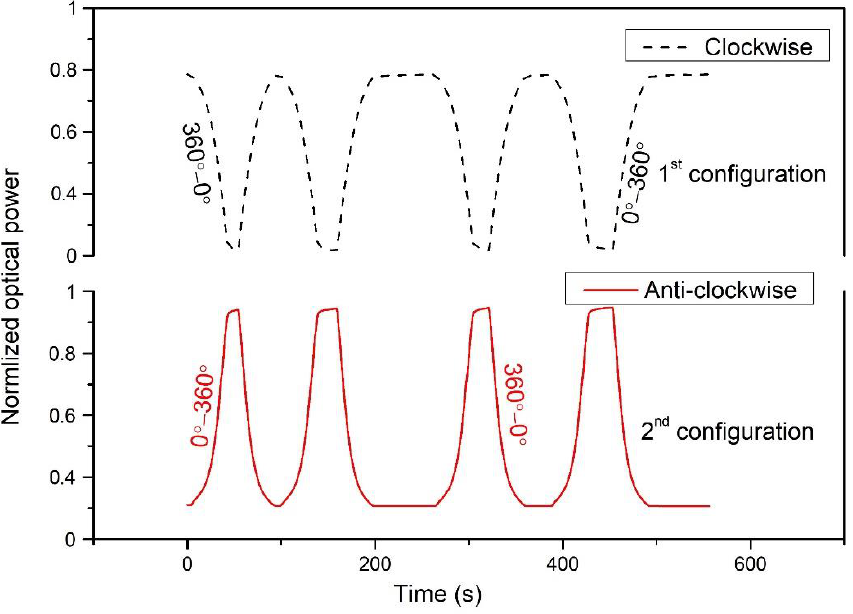
Figure 3. The clock and anti-clockwise rotation of the sensor over time. In Figure 3, as the rotation shifted from 0 ◦ –360 ◦ , the curve began to rise due to the increase in coupling power. Throughout the curve’s rise, the twisted fiber’s bending radius decreased. At 360 ◦ , the coupling power became constant and then rotated in reverse, starting from 360 ◦ to 0 ◦ . The rising curve indicates the increase in the coupling power, while the decreasing curve indicates the decrease in the coupling power. Since the bend radius was kept to a minimum, the start rotation was anti-clockwise. After a 360 ◦ change, the bending radius was the largest, and the illuminating fiber’s radiation power loss was significantly higher. At 360 ◦ , the coupling power changed clockwise during this period with the decrease in the bending